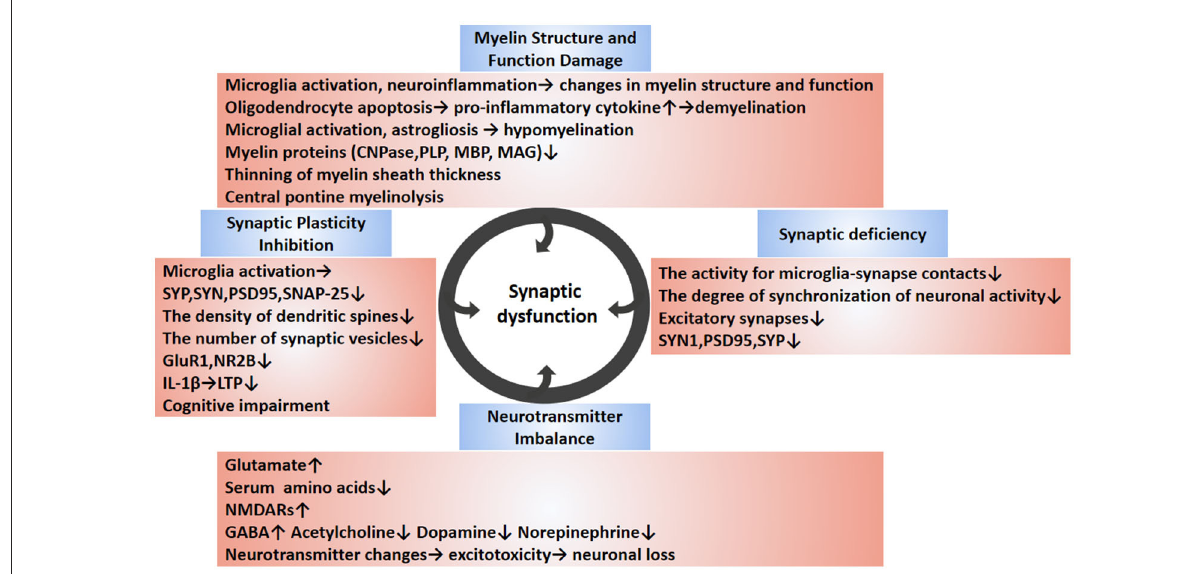
FIGURE2 Synaptic dysfunction of SAE. The synaptic dysfunction of SAE is multifactorial mediated (circles indicate). SAE-induced neuroinflammation can cause cellular changes in brain tissue, such as the release of pro-inflammatory cytokines from activated glial cells, resulting in synaptic and neuronal damage. The abnormal synapse-related changes during SAE are diverse and include reduced synapse number, reduced expression of synapse-associated proteins, abnormal neurotransmitters, inhibition of synaptic plasticity, and changes in myelin. Disruption of synapses leads to inhibition of synaptic plasticity. Abnormalities in neurotransmitters can cause excitotoxicity and lead to neuronal death. Demyelination and hypomyelination can inhibit synaptogenesis, which can lead to neurological dysfunction. In conclusion, the causes of synaptic damage are multiple factors, and these synaptic abnormalities affect the synaptic transmission, ultimately leading to cognitive and memory impairment. The blue boxes describe relevant changes in synaptic dysfunction reported in SAE studies. The pink boxes outline the changes in specific molecules of action and their underlying pathological mechanisms. SAE, sepsis-associated encephalopathy; SYP, synaptophysin; PSD95, postsynaptic density protein 95; NR2B, N-methyl-D-aspartate receptor subunit 2B; GluR1, Amino-3-hydroxy-5-methy-4-isoxazole propionate (AMPA) receptor subunit; SNAP-25, synaptosomal associated protein of 25 kD; LTP, long-term potentiation; CNPase, 2 ′ , 3 ′ -cyclic nucleotide 3 ′ -phosphodiesterase; MBP, myelin basic protein; PLP, proteolipid protein; MAG, myelin associated glycoprotein; C3a, complement 3a;